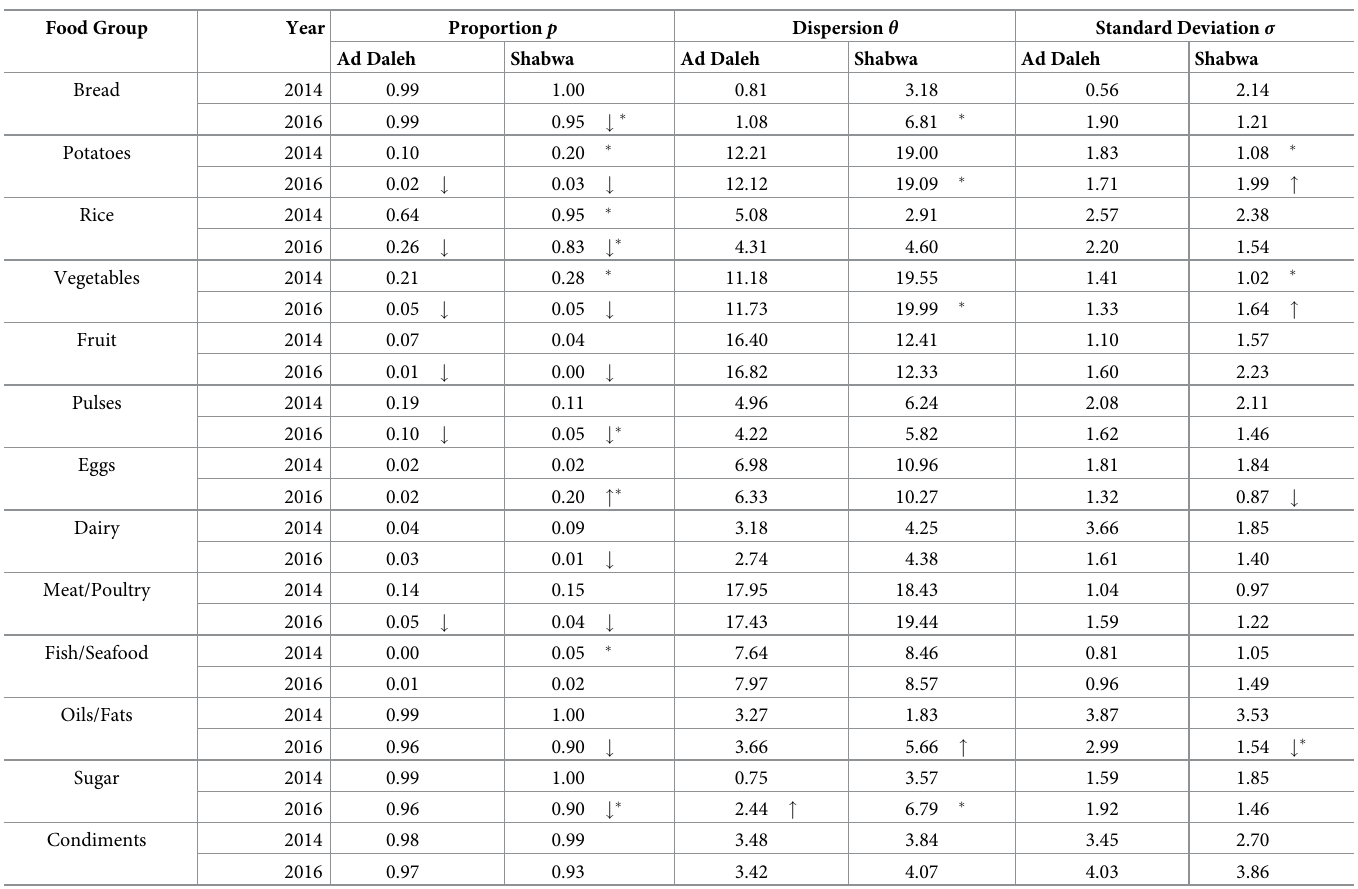
Asterisks ( � ) indicate non-overlapping 95% HPD intervals for the two regions, while non-overlapping 95% HPD intervals across years within each region are indicated by arrows for increasing ( " ) or decreasing ( # )